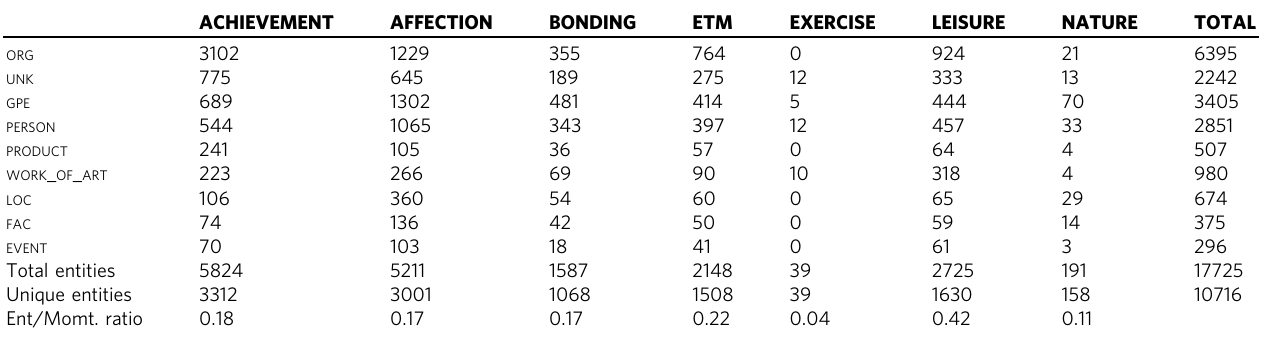
Table 4 Number and types of entities per